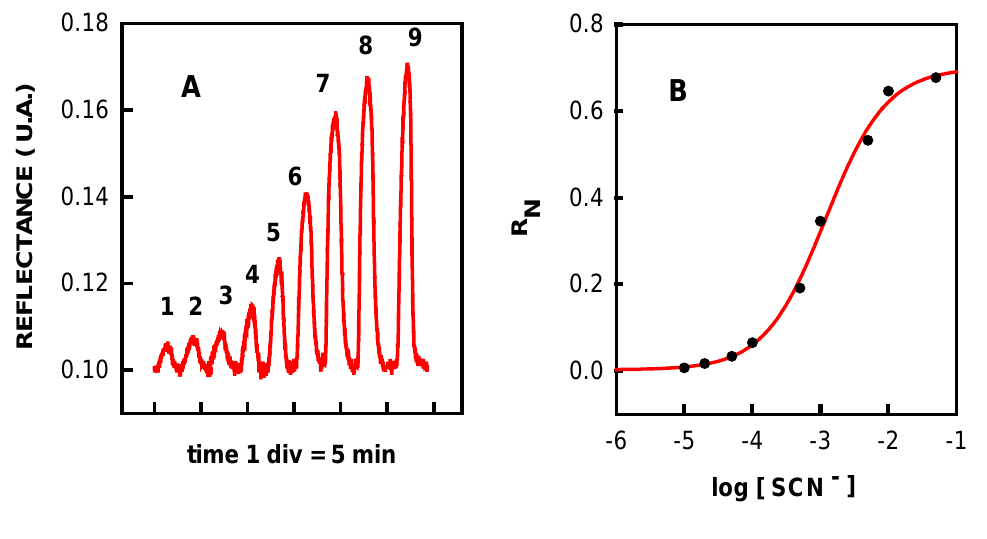
Figure 2. (A) Response to different SCN - concentrations: (1) 0, (2) 1x10 -5 , (3) 5x10 -5 , (4) 1x10 -1 , (5) 5x10 -4 , (6) 1x10 -3 , (7) 5x10 -3 ; (8) 1x10 -2 , (9) 5x10 -2 M. (B) Calibration